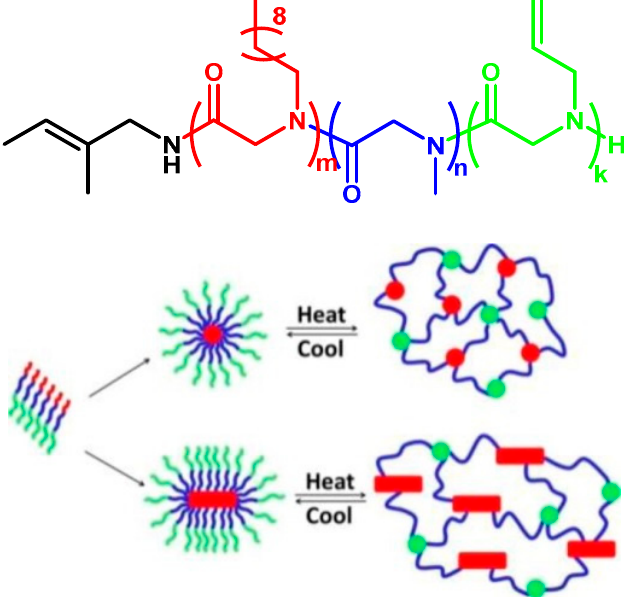
Figure 6. Schematic illustration of the gelation mechanism of the ABC triblock copolypeptoids poly( N -allyl glycine)- block -poly( N -methyl glycine)- block -poly( N -decyl glycine) in aqueous solution. Reprinted with permission from [57]. Copyright 2016, American Chemical Society.